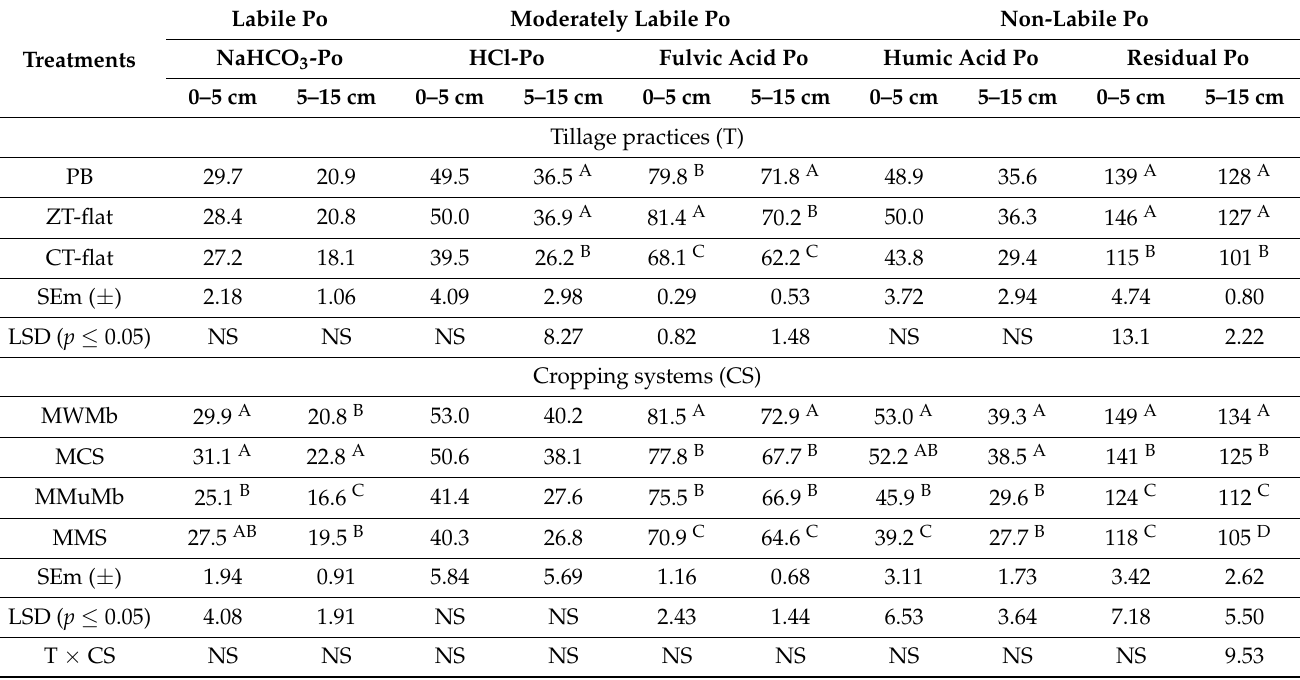
Table 4. Long-term impact of different tillage practices and maize-based crop rotation on organic P fractions (mg kg − 1 ) at different soil